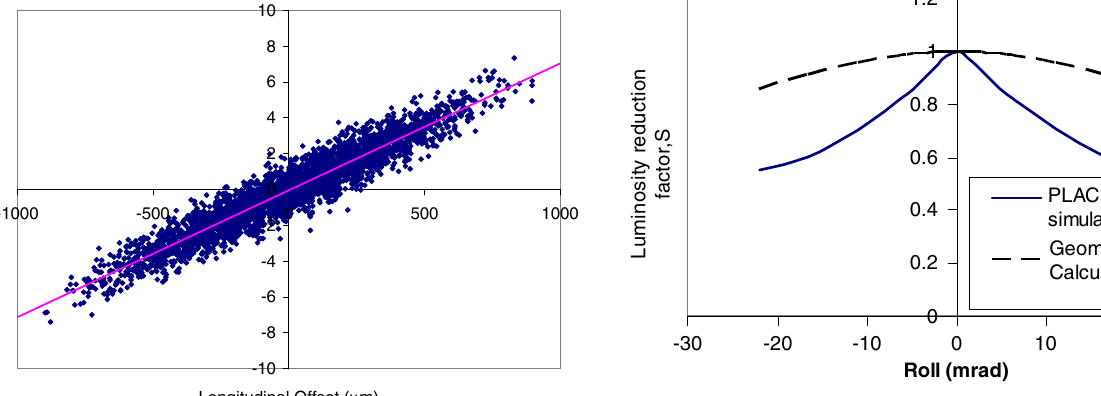
FIG. 5. (Color) Luminosity reduction factor for various roll misalignments of the ILC crab cavities comparing simulations and analytic